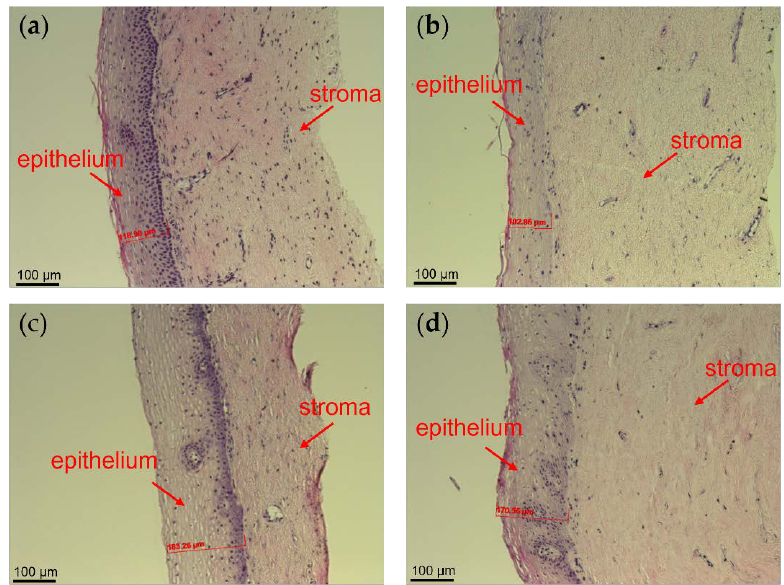
Figure 6. H&E staining for the morphology of human cervical tissues: ( a ) pre − treatment, ( b ) post − treatment with free MK − 2048, ( c ) post − treatment with MK − 2048 PNP, and ( d ) post − treatment with MK − 2048 PNP film. Epithelium thickness was measured as shown in respective images. Nuclei were stained in blue.